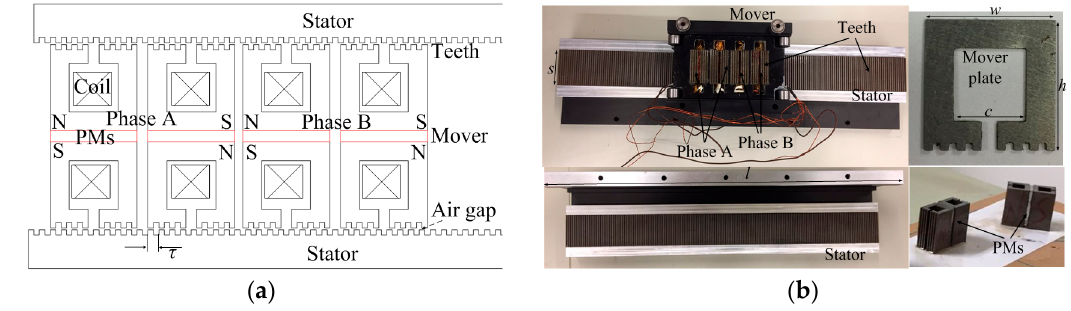
Figure 2. ( a ) Sectional view of the magnetic path of the machine and ( b ) the prototype. Table 1. The main specifications of the generator.